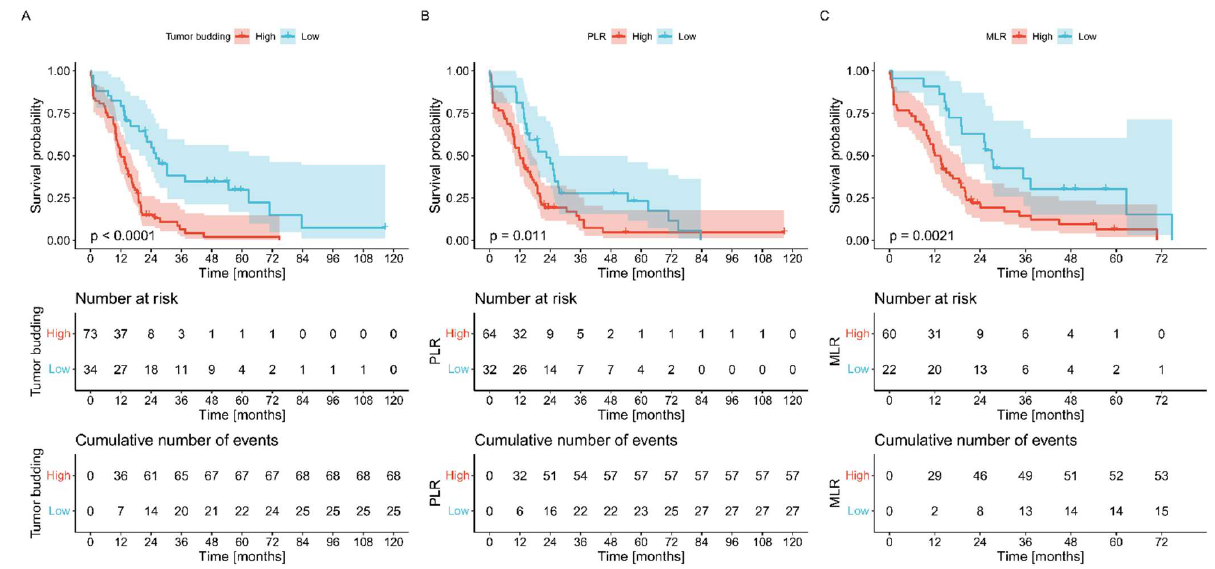
Figure 5. The Kaplan–Meier plots were stratified by budding grade ( A ), PLR values ( B ), and MLR values ( C ). p -values were calculated with log-rank.